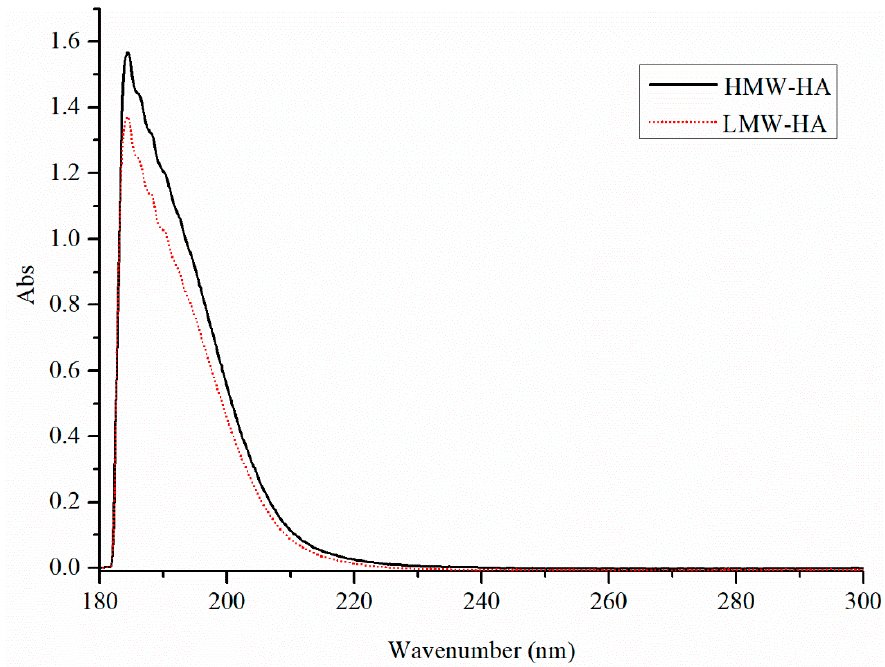
Figure 5. UV–VIS absorption spectra of HMW-HA and LMW-HA.